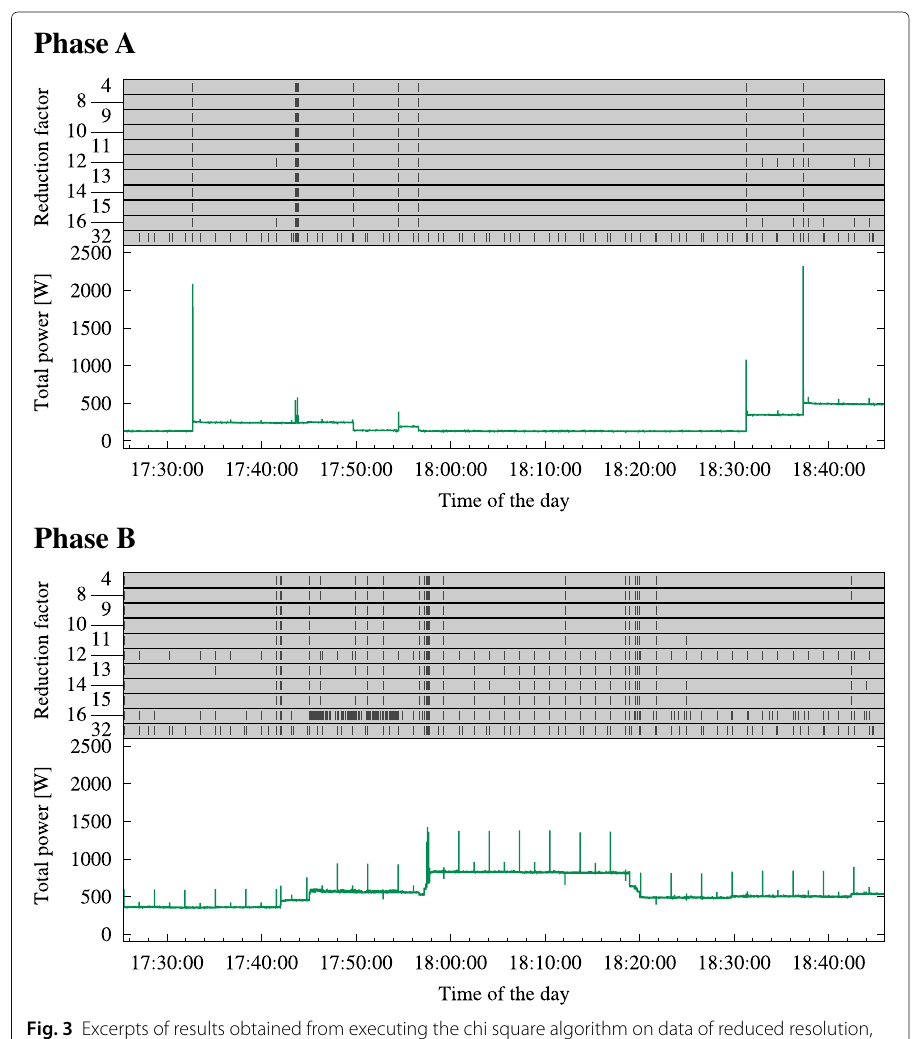
Fig. 3 Excerpts of results obtained from executing the chi square algorithm on data of reduced resolution, showing the detected events on both phases